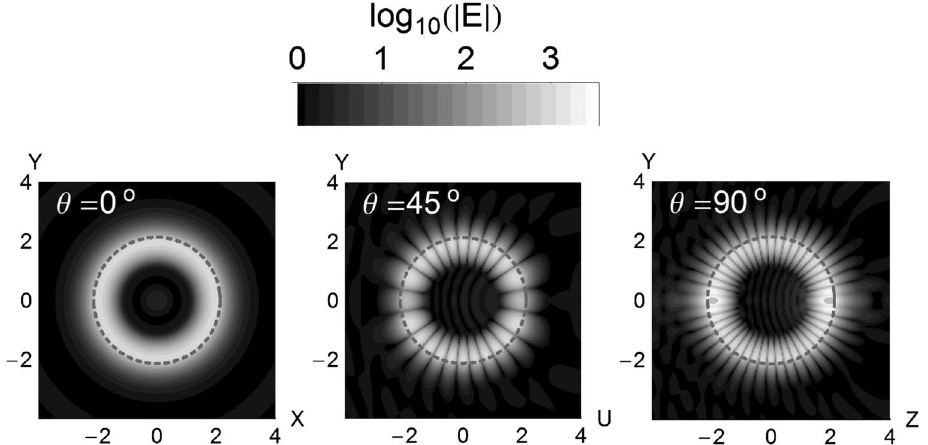
.FIG. 3. The accuracy of the solution, defined as (cid:1) E scatterer (left figure). The great circle lies in the orthogonal plane to the vector 1 (cid:1)(cid:1) corresponding distribution of the tangent electric field.